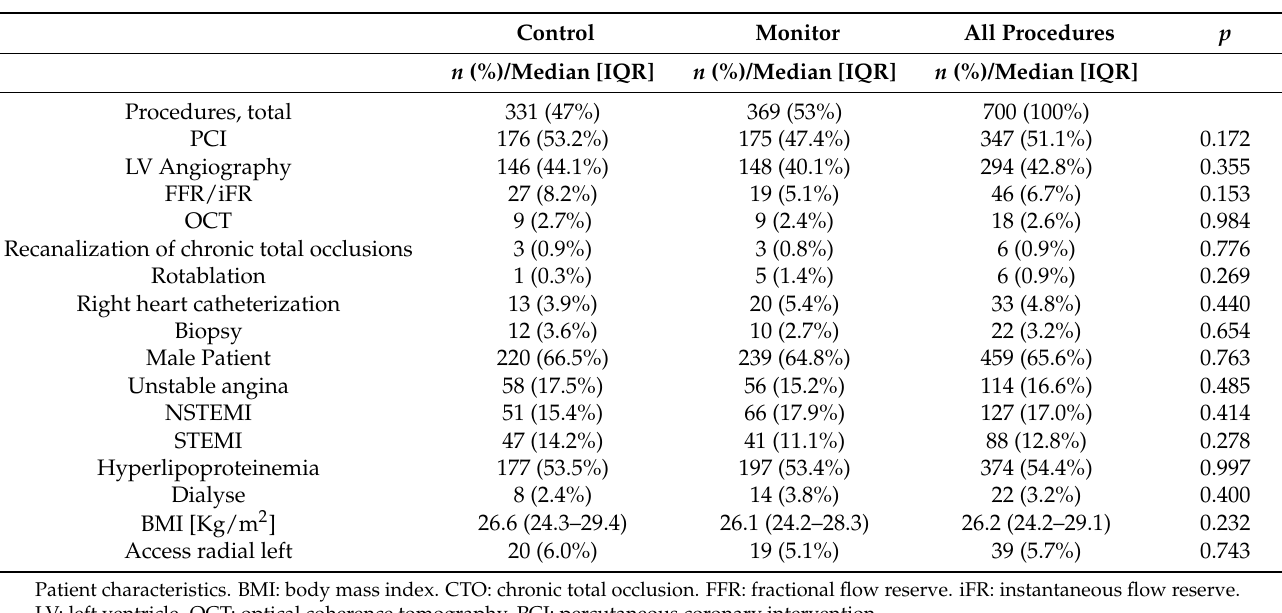
Table 1. Procedure characteristics.